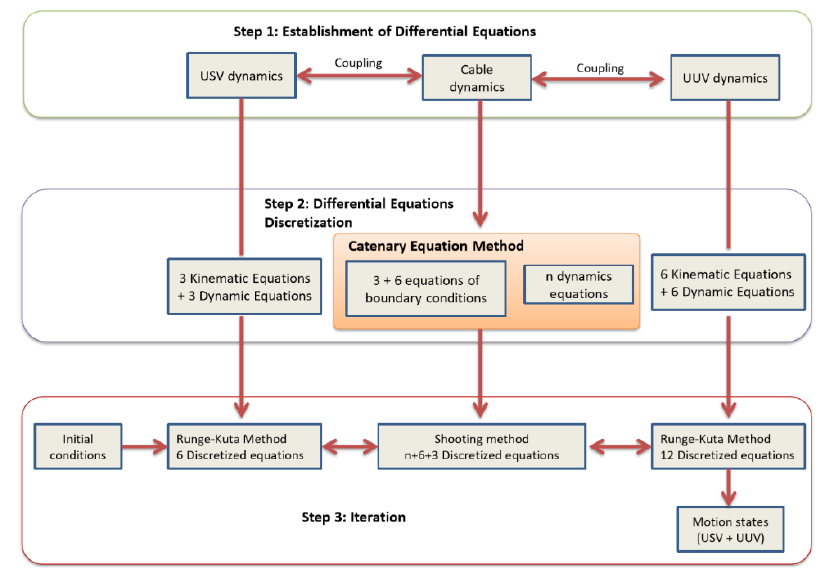
Figure 13. The model-based simulation process.